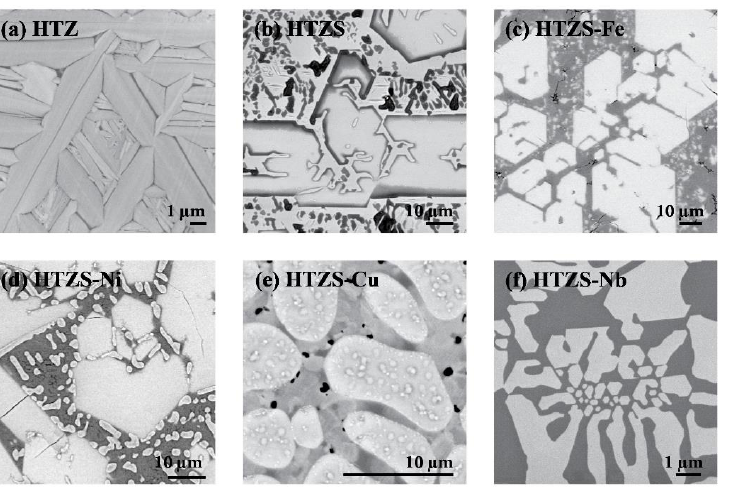
Figure 2. SEM BSE images of ( a ) HfTiZr (HTZ), ( b ) HfTiZrSn (HTZS), ( c ) HfTiZrSnFe (HTZS-Fe), ( d ) HfTiZrSnNi (HTZS-Ni), ( e ) HfTiZrSnCu (HTZS-Cu), ( f ) HfTiZrSnNb (HTZS-Nb). For details, see Table 3 and the text.